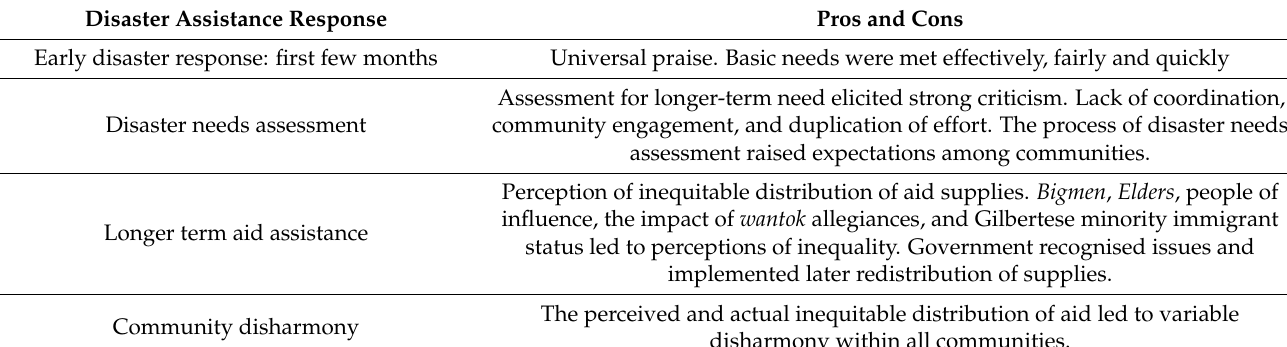
Table 7. 2007 West Solomons Tsunami Disaster: Assistance response and community impacts their communities to a greater or lesser